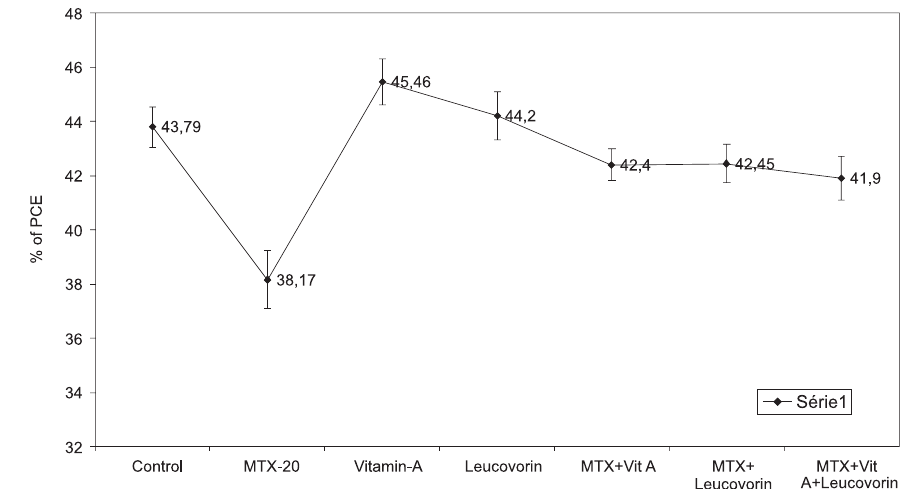
Figure 2 - The percentage of polychromatic erythrocyte in various gropus of rats. Error bar indicates ± SE (n=8), Anova significance,